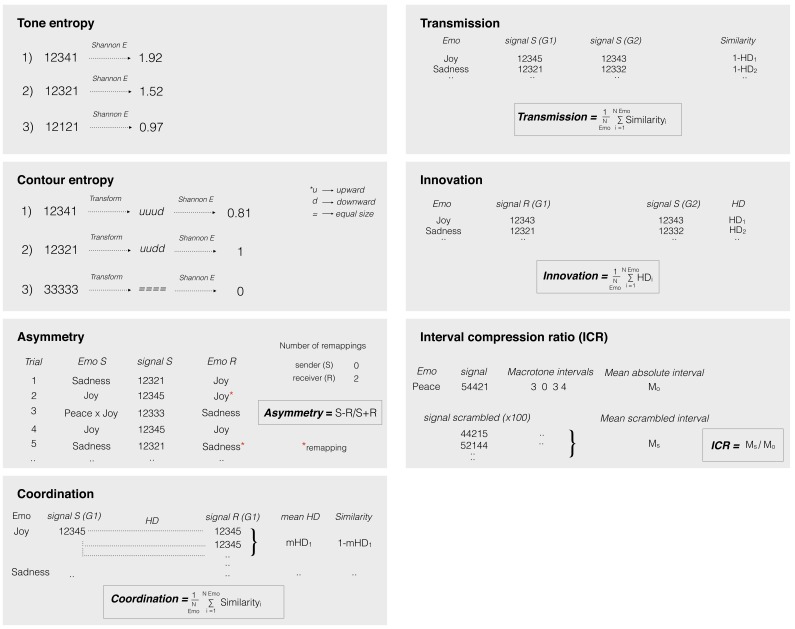
Schematic example of the formal measures used on signaling game data.Tone and Contour entropy: A single entropy value (H) was computed for each tone sequence (Tone entropy) and the relative contour transform (Contour entropy) by using the Shannon entropy formula. These measures are different indicators of the complexity of a melodic signal. Asymmetry: we calculated asymmetry in Game 2 as the difference of the number of code changes introduced by the sender (S) and by the receiver (R) across all emotions, divided by the total number of code changes ((S–R)/(S+R)). This measure reflects the direction of information flow and ranges from −1 (the receiver adapts his mappings to the ones used by the sender) to 1 (viceversa). In Game 1, the sender never changes the signal-to-emotion mappings and asymmetry is −1 by design. Coordination: we computed coordination in Game 1 as the mean similarity (1-Hamming distance) between the signal (tone sequence or contour transform) used by the sender for a given emotion and the set of signals mapped by the receiver to the same emotion during the second half of the game (between-player measure). A mean value was computed across all five emotions. It represents the extent to which the sender and receiver shared their mappings at the end of the game and it ranges from 0 (different signaling system) to 1 (shared signaling system). Transmission: this measure was computed as the similarity of signals (tone sequences or contour transforms) mapped to the same emotion and used by senders of adjacent games (between-player measure). A mean value was computed across emotions. It ranges from 0 (the sender in game two reproduced a new signaling system) to 1 (the sender in game two faithfully transmitted the signaling system received in game 1). Innovation: this measure was calculated as the mean hamming distance (HD) between the signal (tone frequency or contour transform) mapped with the greatest frequency to a given emotion in the second half of Game 1 by the player as receiver and the signal reproduced with major frequency for the same emotion in Game 2 by the same player as sender (within-player measure). A mean value was computed across the five emotions, ranging from 0 to 1. Values close to one indicate that a significant number of changes were introduced in the signaling system by the participant. Interval compression ratio: The interval compression ratio (ICR) (Tierney et al., 2011) was calculated as the ratio between the mean absolute interval size (in macrotones) of a tone sequence randomly scrambled (N = 100), divided by the mean absolute interval size of the original sequence. A mean value was computed across the five emotions. Larger values indicate a bias towards smaller (proximal) intervals. Scripts to compute these measures are available at: https://doi.org/10.5061/dryad.2jj01c1 (folder ‘signaling games’).